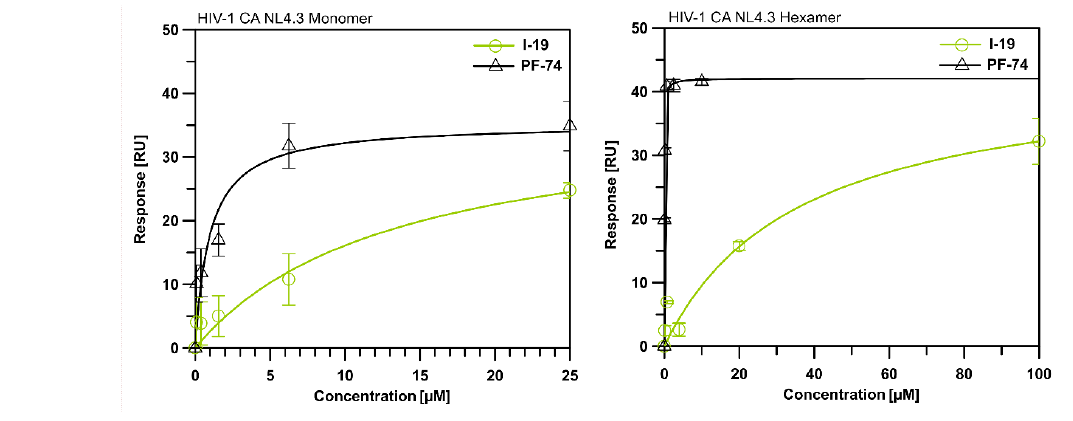
Figure 2. SPR isotherms derived from the equilibrium stage of compounds I-19 and PF-74. All values represent the average response from at least 3 replicates with standard deviations.